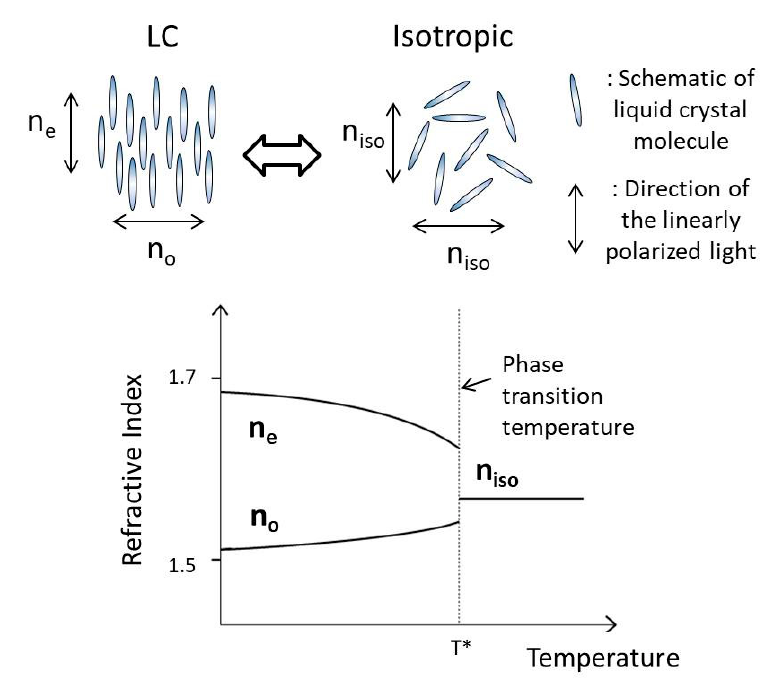
Figure 3. The refractive index change based on the molecular orientation of azobenzene liquid crystals (LC).